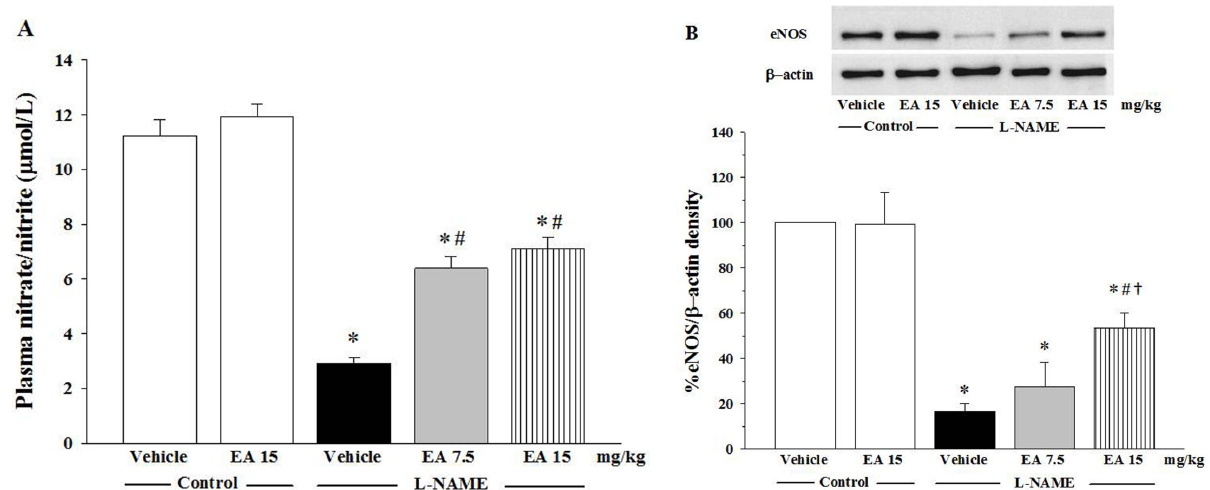
Figure 2. Effect of ellagic acid on ( A ) nitrate/nitrite production ( n = 7) and ( B ) eNOS protein expression ( n = 5). Values are expressed as mean ± SEM, * p < 0.05 when compared to control group, # p < 0.05 when compared to L-NAME group and † p < 0.05 when compared to L-NAME+EA 7.5 mg/kg group.